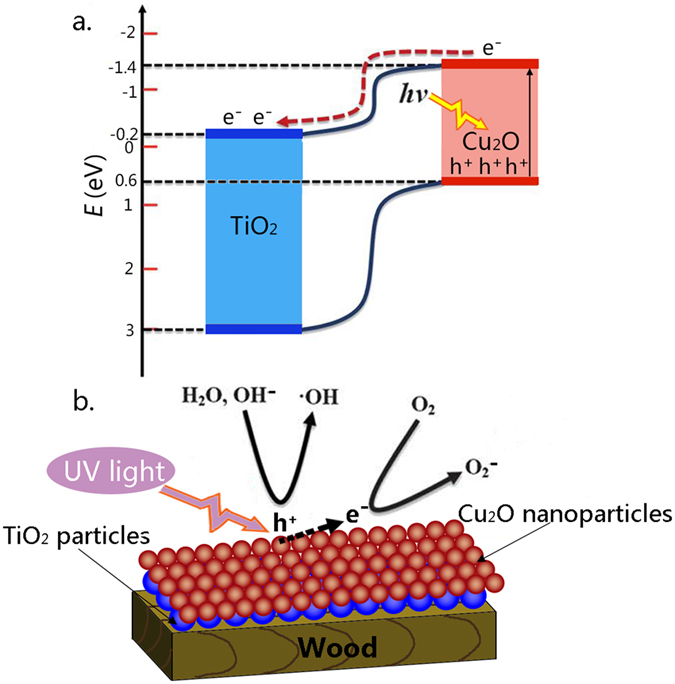
(a) Illustration of the photocatalysis mechanism at the TiO2/Cu2O heterostructures, and (b) possible scheme for negative oxygen ions production on the TiO2/Cu2O-treated wood under UV irradiation.